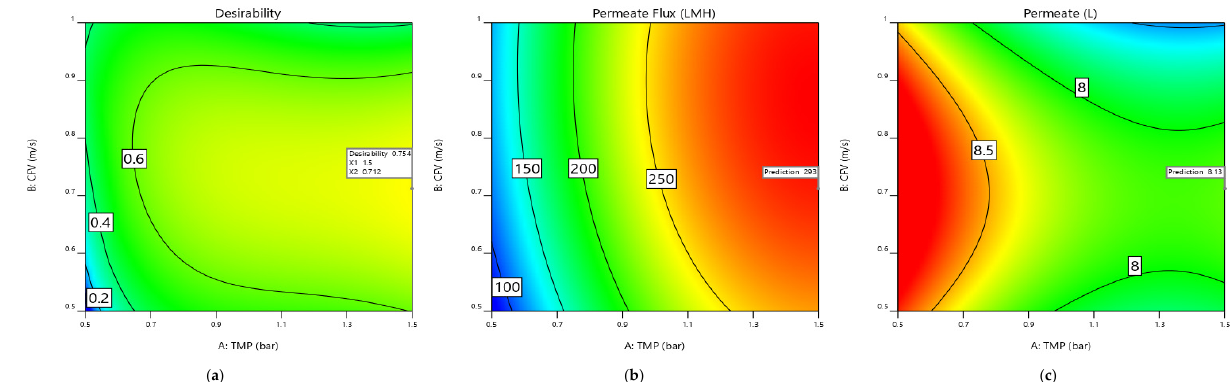
Figure 10. Optimizing the process parameters to maximize the membrane permeate flux and permeate volume. ( a ) Desirability solution for the interaction factors A: TMP, B: CFV, and C: BP cycle at 85.1951 s ≈ 85 s. ( b ) Membrane permeate ‐ flux optimization at the desirability values of A: TMP =1.5 bar, B: CFV ≈ 0.71 m/s, and C: BP cycle ≈ 85 s. ( c ) Membrane permeate ‐ volume optimization at the desirability values of A: TMP =1.5 bar, B: CFV ≈ 0.71 m/s, and C: BP cycle ≈ 85 s.